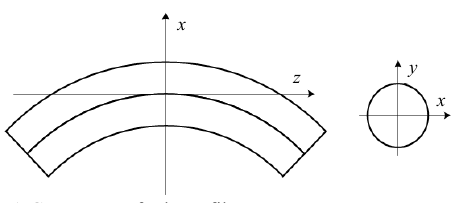
Fig. 1 Geometry of a bent